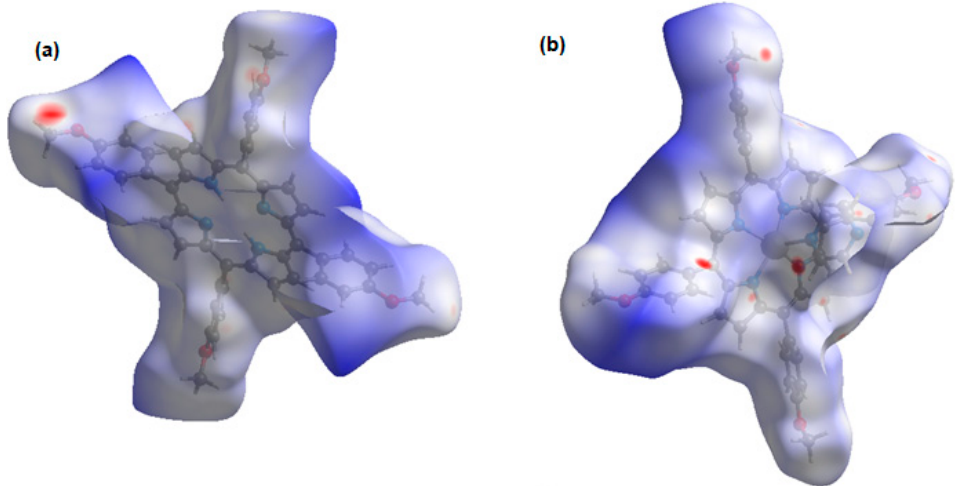
8 of 20 positive d norm results in a longer r vdw . White, red, and blue color isosurfaces are usually revealed by d norm , with bright red spots highlighting shorter contacts, white areas reveal-